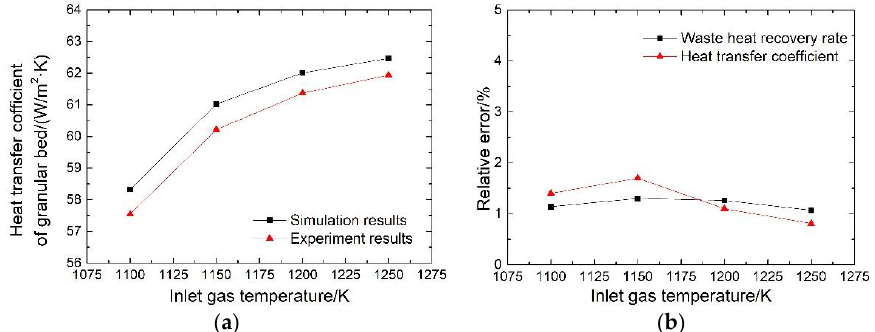
Figure 9. Comparison of experimental and simulation results. ( a ) The influence of gas temperature on the coefficient. ( b ) Variation curve of relative error.